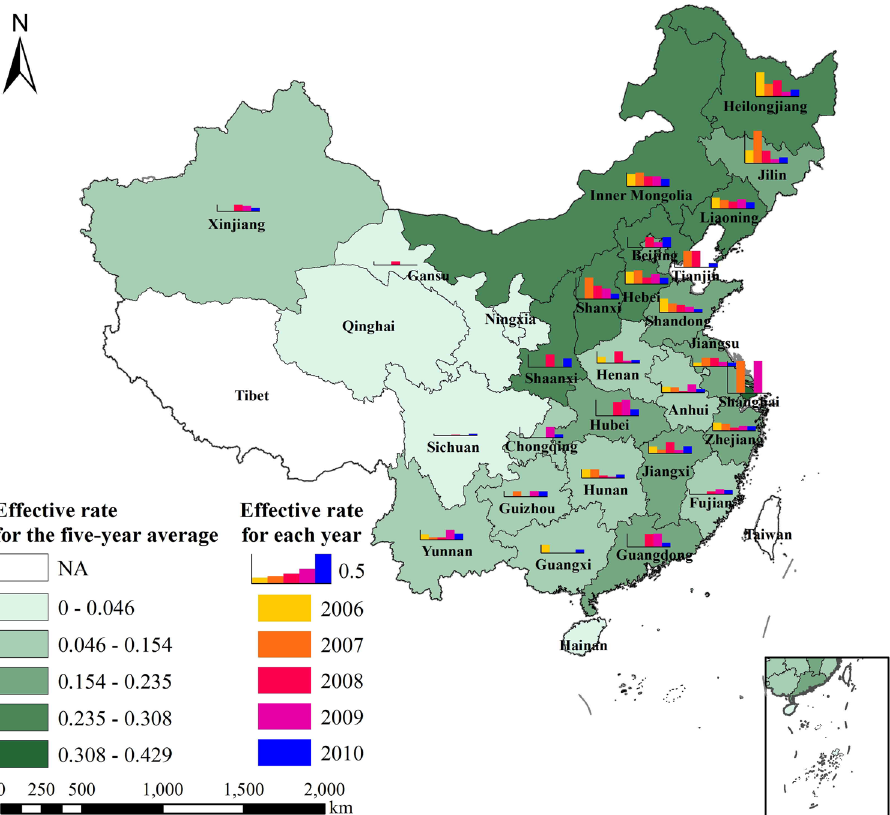
Figure 2. The effective rates (i.e., effective projects/total number of projects) was calculated for each province in China. Map was generated using ArcGIS 10.3